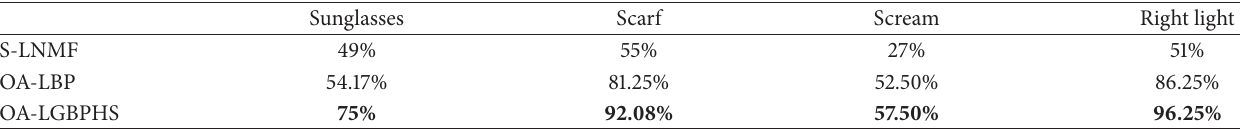
Table 3: Robustness to different facial